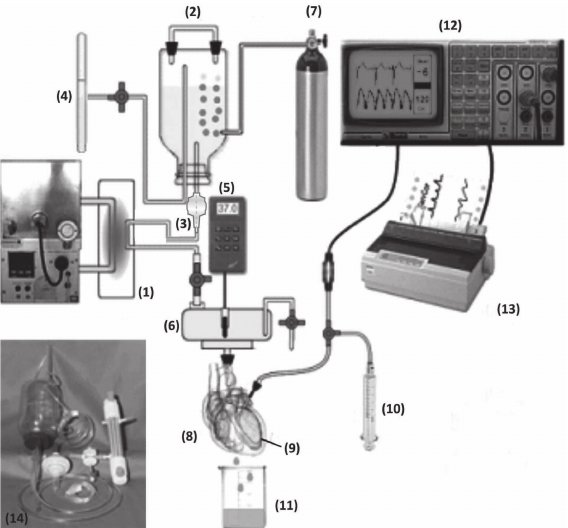
Fig. 2 – Isolated Heart System Diagram - 1. Termal exchanger, 2. Perfusate reservoir. 3. Microfilter (20 ì), 4. Gauge/Manometer, 5. Telethermometer, 6. Chamber, 7. Carbogen (95% 02 +5% C02), 8. Heart, 9. Intraventricular balloon, 10. Drug injector, 11. Flow Collector, 12. ECG and Ventricular Pressure monitor, 13. Printer, 14. Disposable set